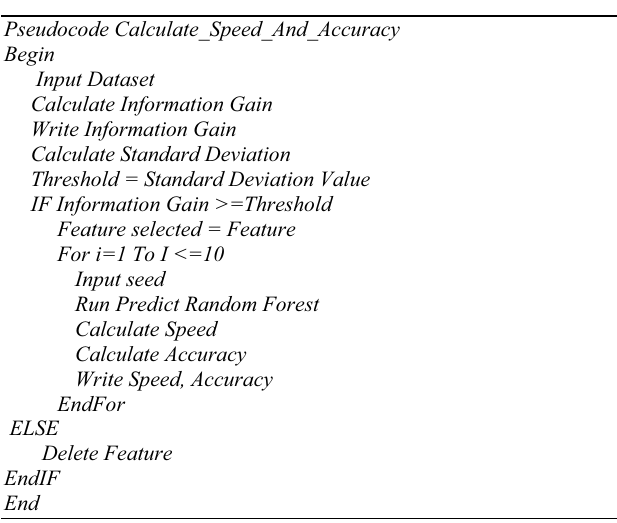
Algorithm 2. The proposed algorithm and calculate speed and